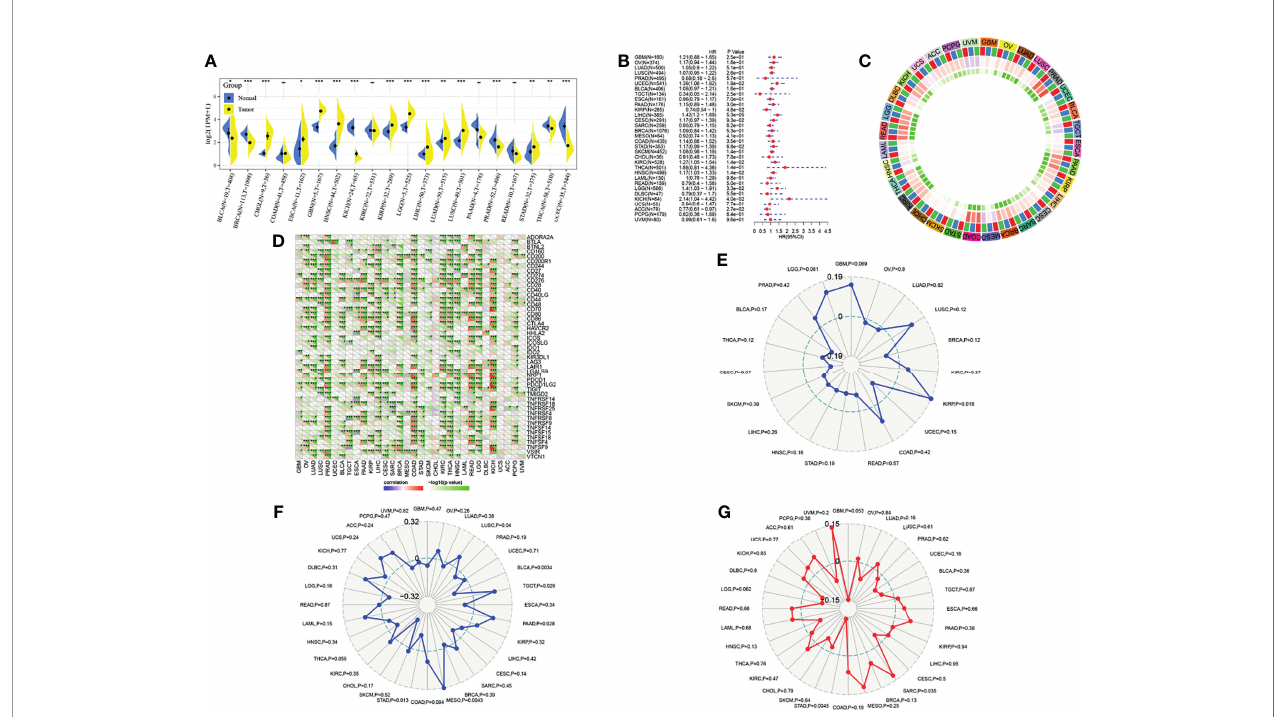
FIGURE 3 | Analysis of GSDME in multiple tumors. (A) Expression of GSDME in multiple tumors (* indicates p < 0.05 for comparison between cancer and paracancer; ** indicates p < 0.01 for comparison between cancer and paracancer; *** indicates p < 0.001 for comparison between cancer and paracancer). (B) Prognostic analysis of GSDME in multiple tumors. (C) Correlation of GSDME with immune microenvironment scores in multiple tumors (blue, minimum color; red, maximum value color; green, minimum p-value color). (D) Correlation of GSDME with immune checkpoints in multiple tumors. (E) Correlation of GSDME with immune neoantigens in multiple tumors. (F) Correlation of GSDME with immune mutational load in multiple tumors. (G) correlation of GSDME with microsatellites in multiple tumors.